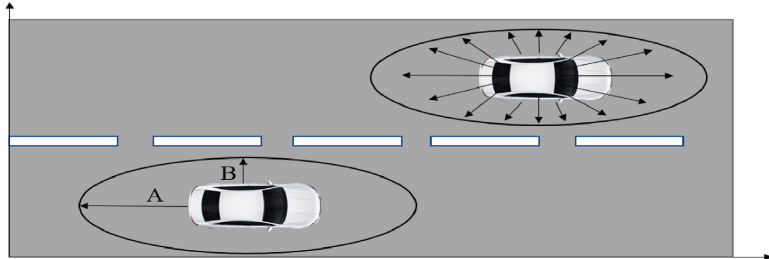
Figure 9: Improved potential field range.